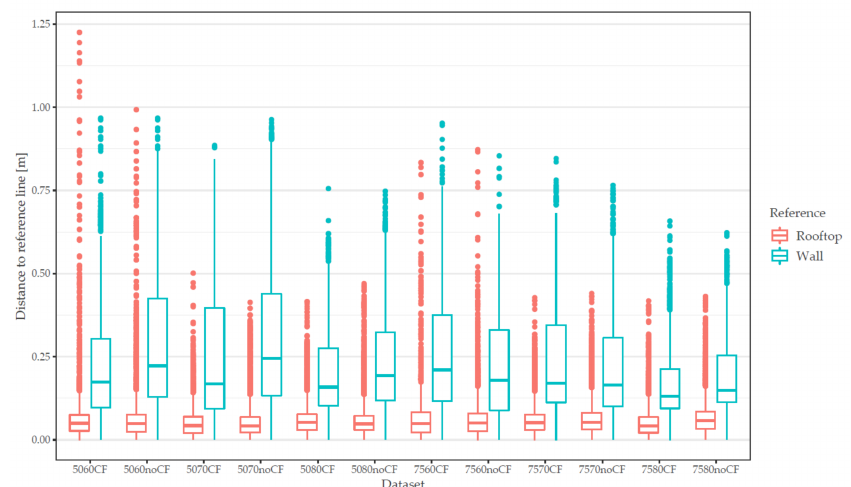
Figure 10. Box-whisker plot of point distances to reference lines separated according to the reference wall and rooftop. Box represents the interquartile range (IQR) with the median; whisker represent 1.5 IQR, points represent outliers. x -axes label refers to flight parameter, e.g., 5060CF means 50% forward overlap, 60% side lap and cross-flight (CF) pattern. Distances reflect the length of perpendicular lines from points to reference lines. Points were created every 10 cm from a line geometry that was derived by feature extraction with the MCG